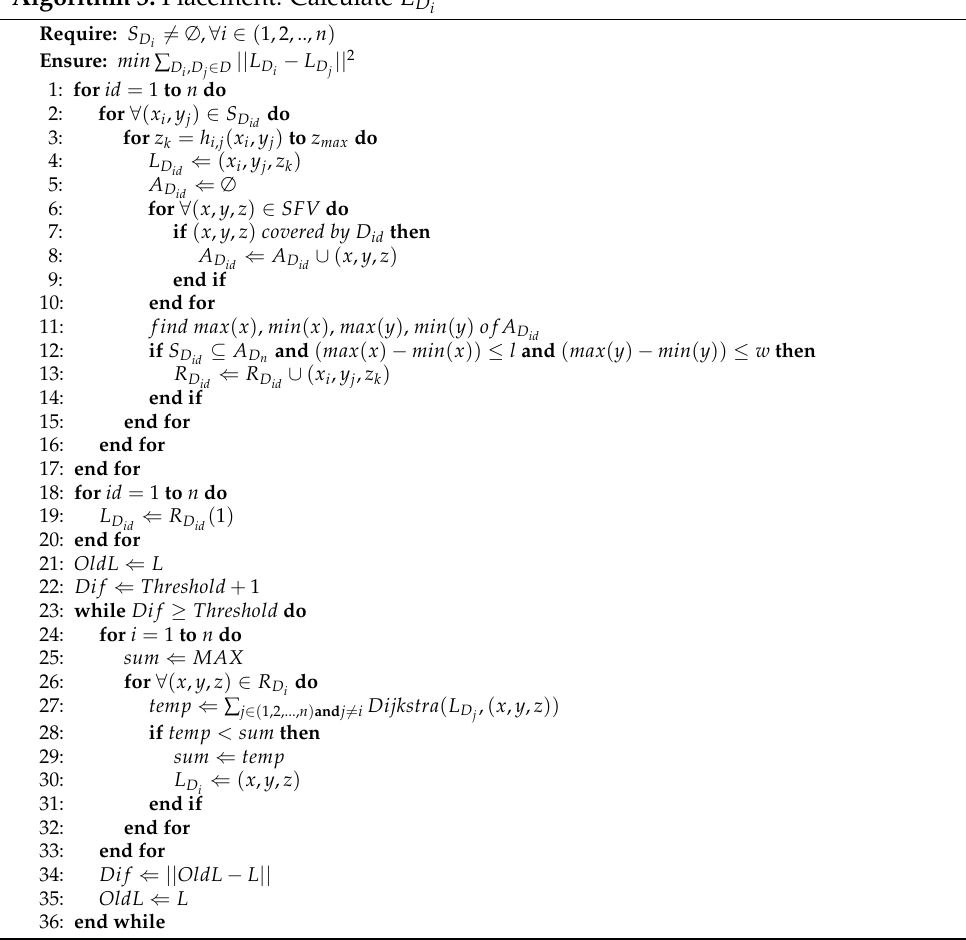
Algorithm 3: Placement: Calculate L D